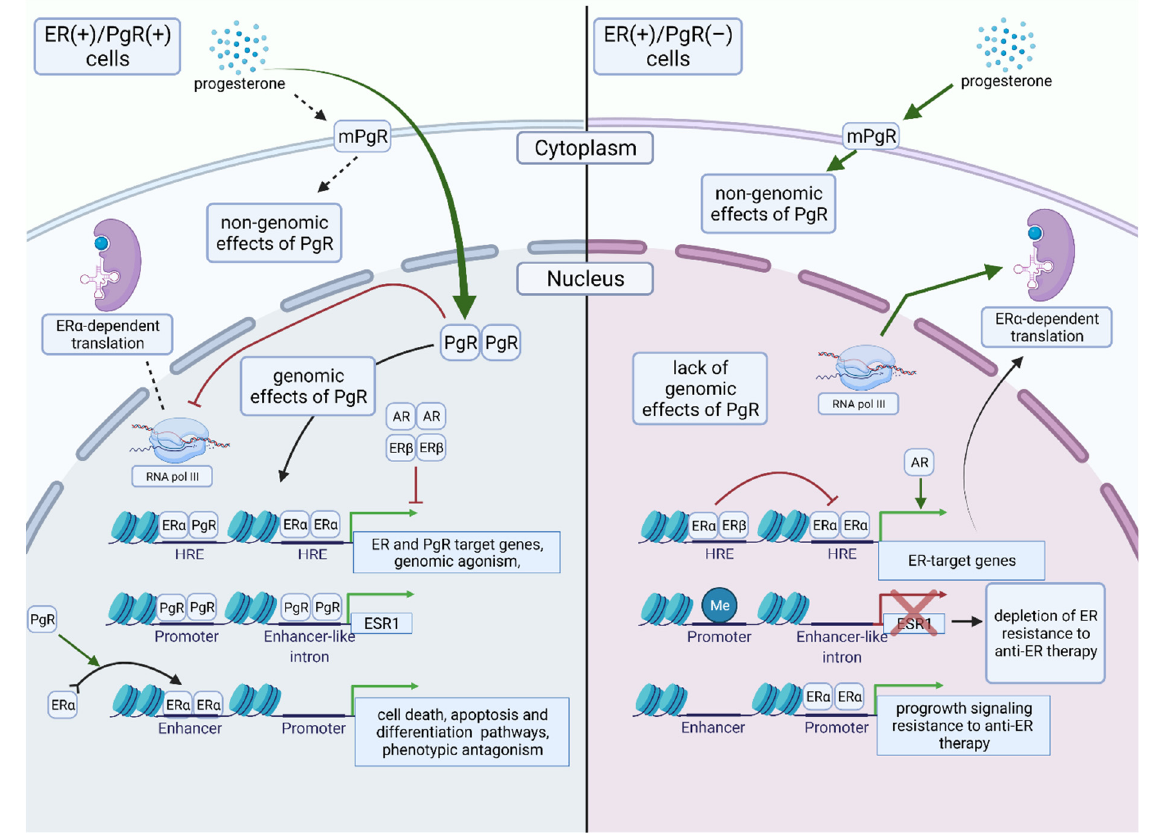
Figure 3. Biology of ER α (+)/PgR(+) and ER α (+)/PgR( − ) breast cancer. Green arrows indicate stimulatory effects, red T-shaped lines depict inhibitory effects. In tumor cells co-expressing ER α and nuclear PgR the latter may exert both non-genomic and genomic effects. It regulates the expression of genes in a similar way to ER α (genomic agonism) but guides ER α binding to chromatin to induce expression of genes associated with good outcomes (phenotypic antagonism). PgR interacts with translational machinery (mainly RNA polymerase III) reducing its availability for ER α -dependent translation. Loss of nuclear PgR results in a shift of ER α role from distant enhancer to proximal promoter activating subset of genes associated with cancer progression. Depletion of PgR increases ESR1 gene promoter methylation and down-regulates ESR1 . Other steroid receptors, i.e., ER and AR may exert different effects on ER α -dependent genes expression in ER α (+)/PgR(+) and ER α (+)/PgR( − ) breast cancers. For details, see text. Abbreviations: AR—androgen receptor; ESR1 — estrogen receptor 1 gene; ER—estrogen receptor; HRE—hormone receptor element; (m)PgR—(membranous) progesterone